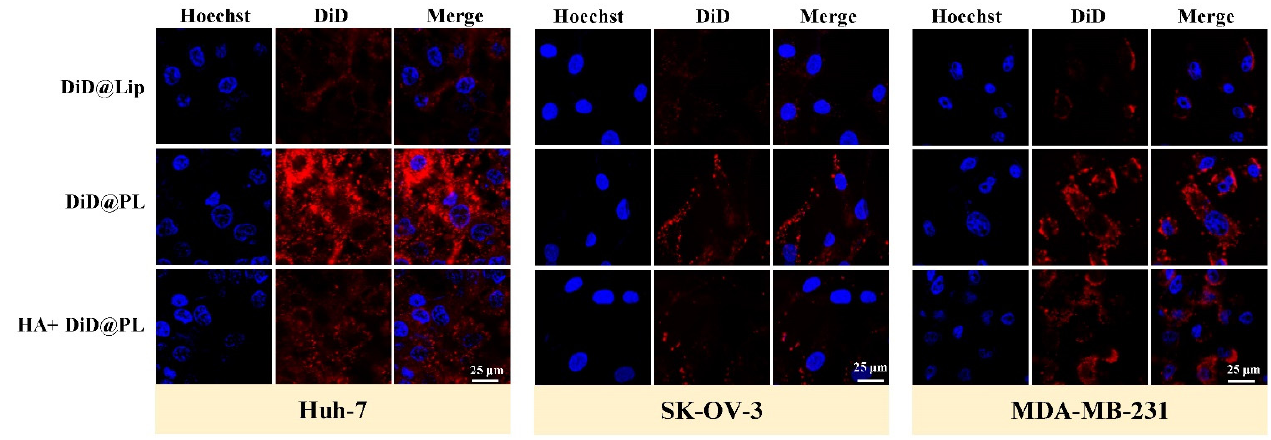
Figure 5. Confocal fluorescence images of Huh-7, SK-OV-3, or MDA-MB-231 cells following 3-h incubation with DiD@Lip or DiD@PL, after a 3-h pretreatment with or without free HA.